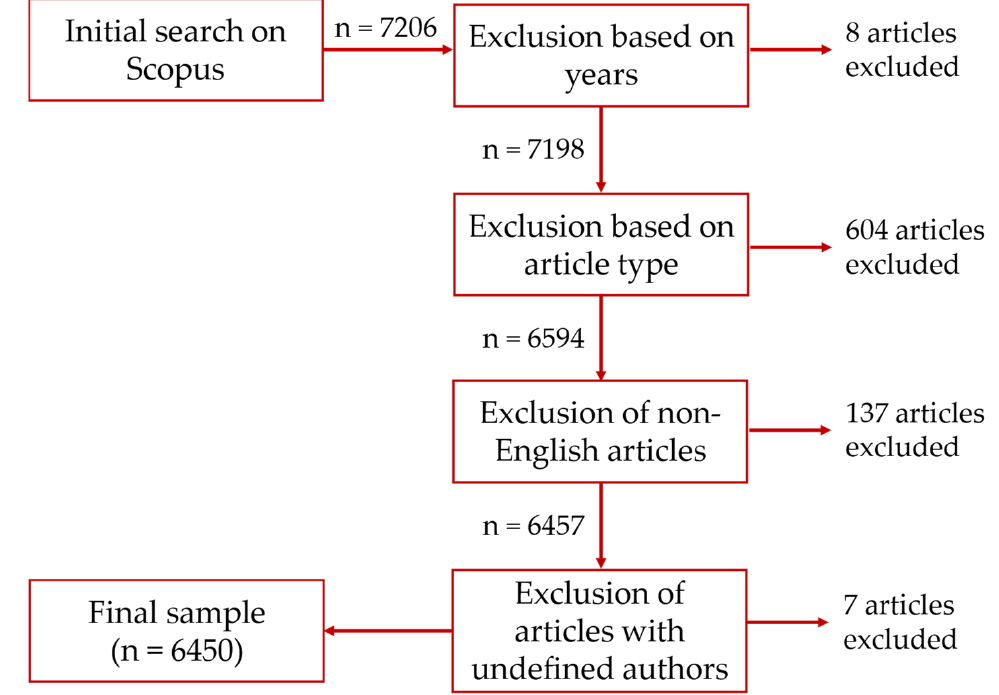
Figure 1. Overview of the literature collection and the exclusion criteria.